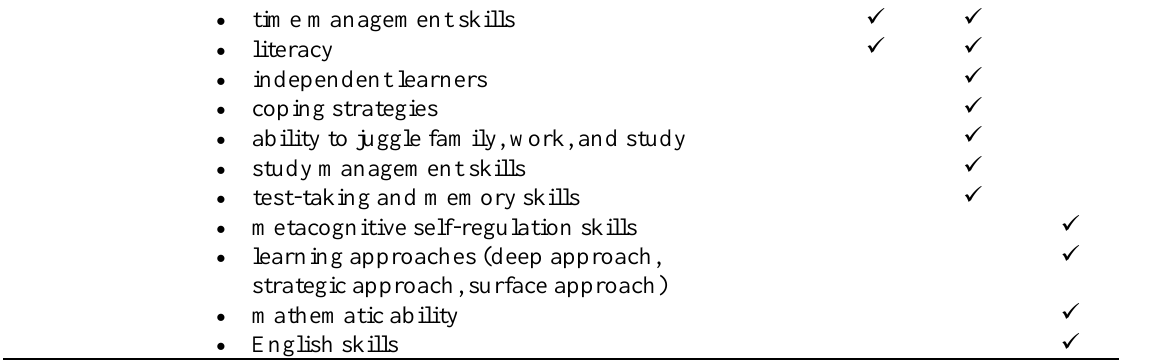
Student Factors Affecting Persistence (Post-Enrolment) Student factors (post-enrolment)